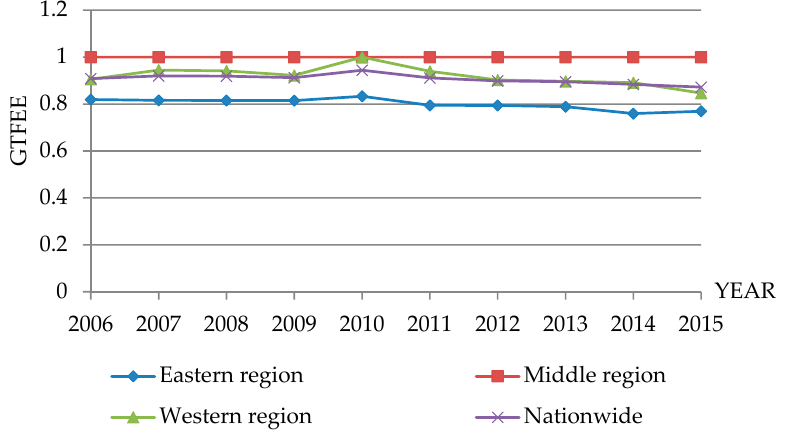
Figure 2. Total factor energy efficiency under the meta-frontier (MTFEE) of three regions during 2006–2015.